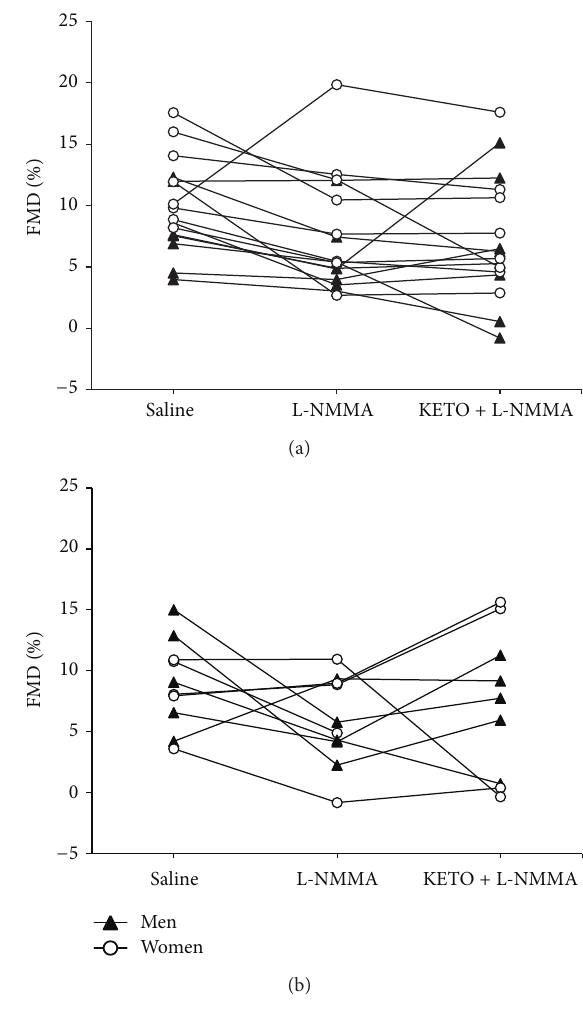
Figure 2: Individual FMD responses to saline, L-NMMA, and KETO + L-NMMA infusion are shown for young (data from young participants have been published previously [8]) (a) and older adults (b). FMD: flow-mediated dilation; L-NMMA: N(G)-monomethyl- L-arginine; KETO: